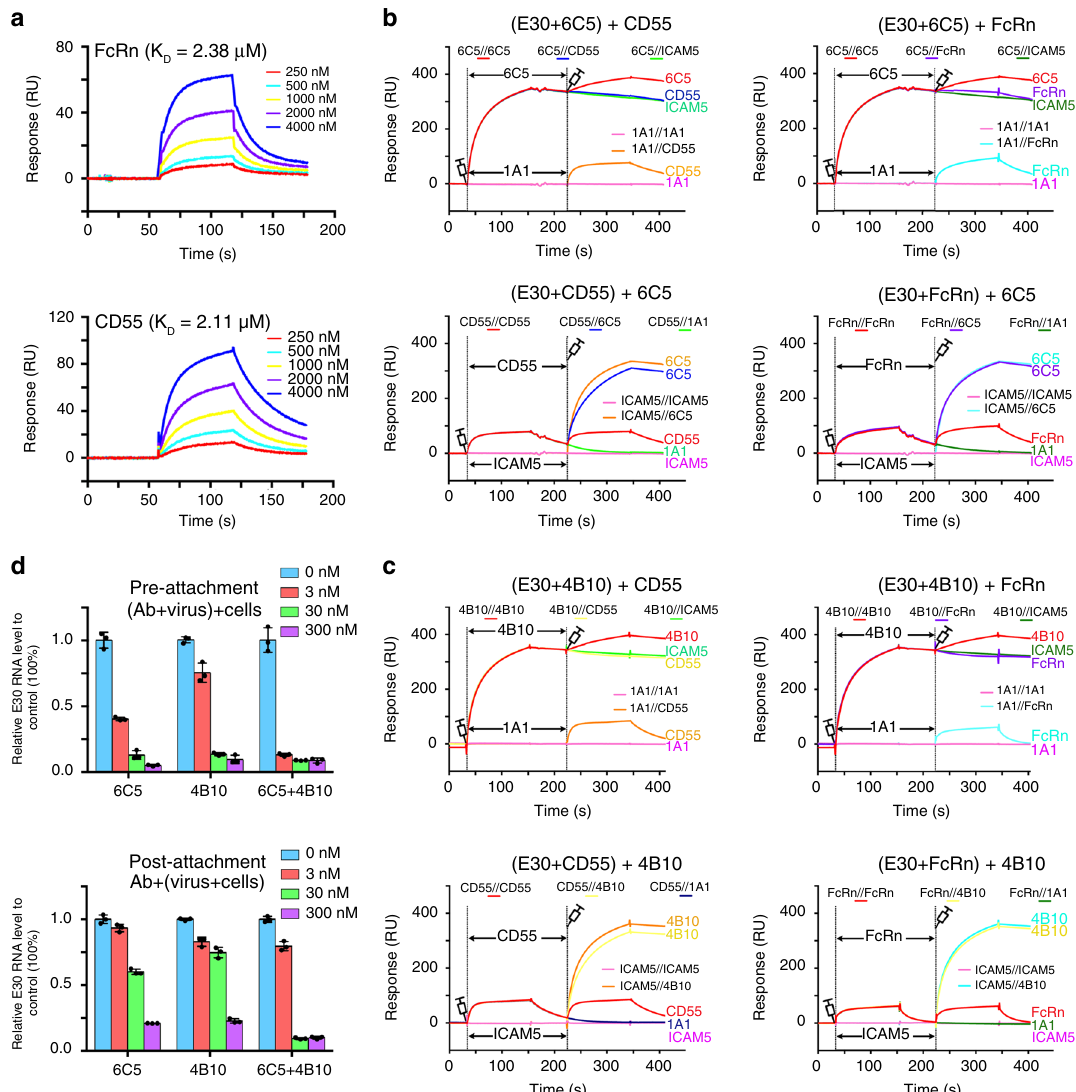
Fig. 2 Blocking of viral attachment receptor CD55 and uncoating receptor FcRn by 6C5 and 4B10. a BIAcore SPR kinetics of FcRn or CD55 binding to E30. The RU curves are fi tted globally to calculate the K D value for FcRn and CD55. b , c Competitive binding between 6C5 or 4B10 and CD55 (left) or FcRn (right). In the upper two diagrams of each panel, 6C5/4B10 was injected fi rst, followed by either CD55, or FcRn, or ICAM5, the uncoating receptor for EVD68; in the lower two diagrams of the counterparts, CD55 or FcRn was injected fi rst, followed by either 6C5, or 4B10, or 1A1. The related control groups were carried out as the other curves show. d Amount of virions remaining on the cell surface, as detected by real-time PCR, when exposed to 6C5 (left) or 4B10 (middle) or the mixture of 6C5 and 4B10 (right) before or after the virions attach to RD cells and the results here were expressed as mean ±